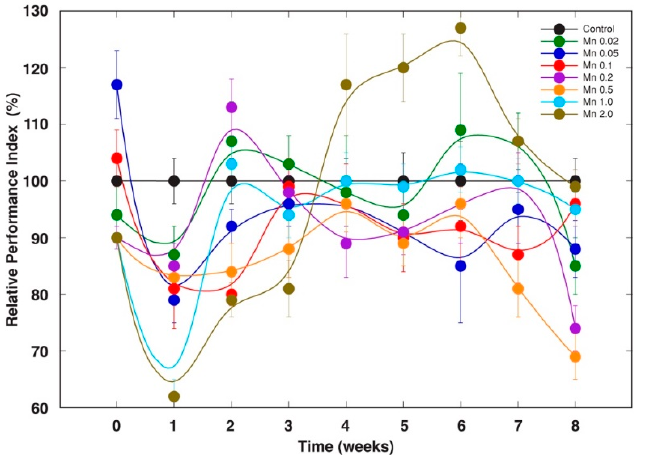
Figure 9. Effect of treatment with different concentrations of Mn on changes in relative Performance Index in leaves of H. maximum (Experiment 2). Data are means ± SE from 5 replicates, each with 2 measurements, for each point.